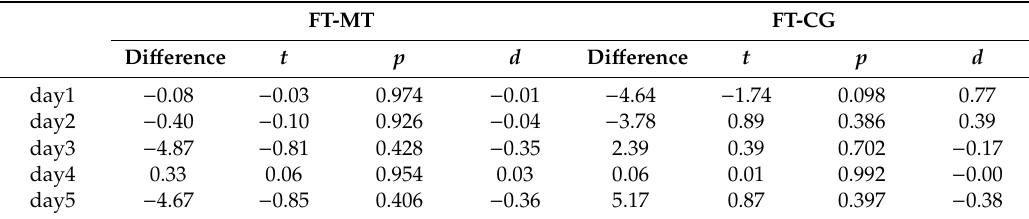
Table A6. Significance and e ff ect sizes for Deck C between the training groups.